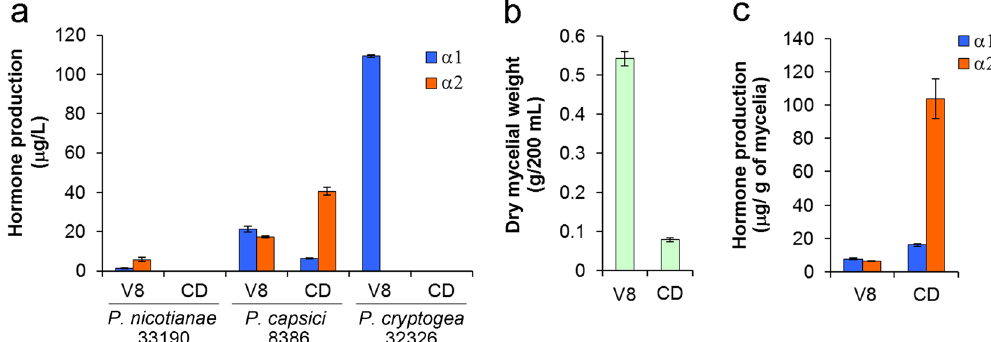
Figure 6. Comparison of the hormone production of three A2 strains in 20% V8 juice and Czapek-Dox (CD) liquid media. ( a ) Mating hormone production of the three indicated A2 strains in μ g L − 1 , ( b ) dry mycelial weight of Phytophthora capsici NBRC 8386 in gram per flask (broth volume: 200 mL), ( c ) mating hormone production per dry mycelial weight of P. capsici NBRC 8386 in μ g g − 1 . The strains were cultured for 7 days. Phytol (1 mg L − 1 ) was added as the precursor of the mating